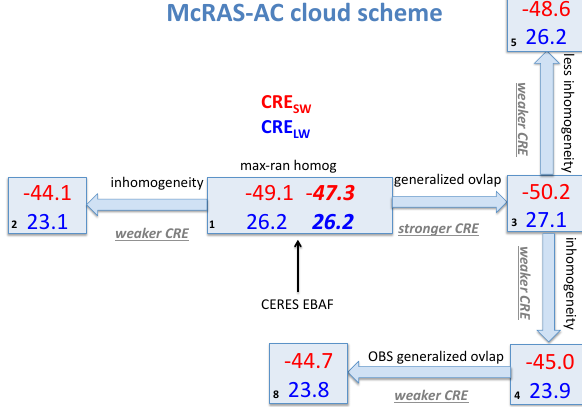
Fig. 3. As Fig. 3, but when McRAS-AC has replaced the GEOS-5 control cloud